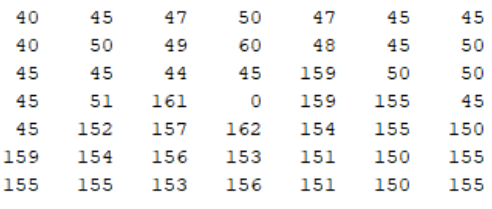
Figure 6. Pixel matrix with noise.